Question: What style of plot is this figure drawn as?
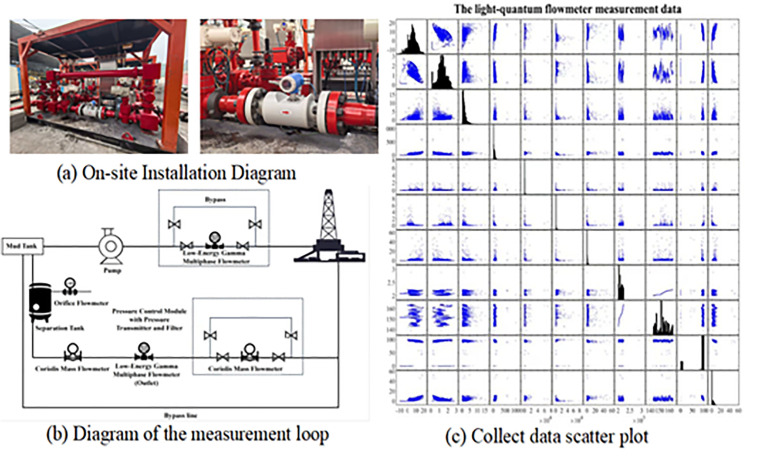
Answer: scatter